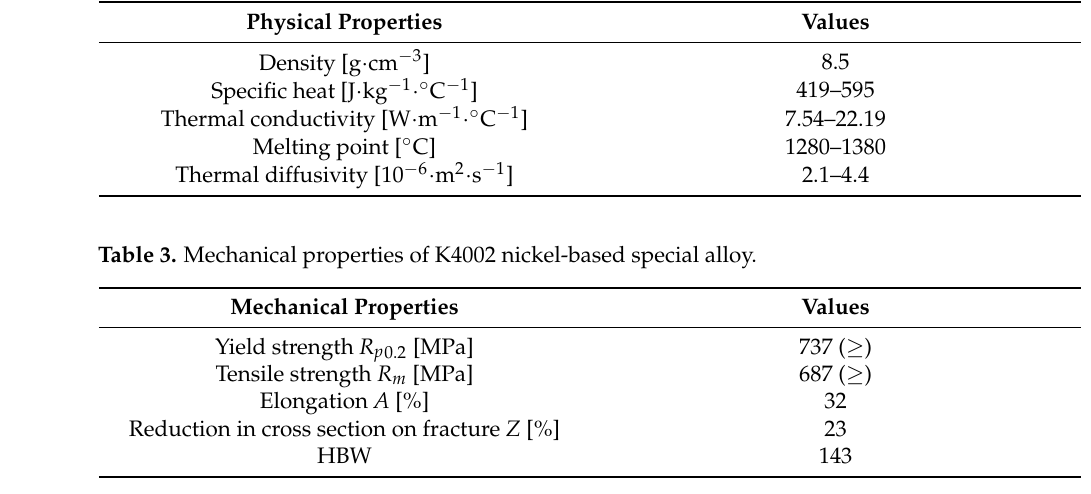
Table 2. Thermophysical parameters of K4002 nickel-based special alloy.